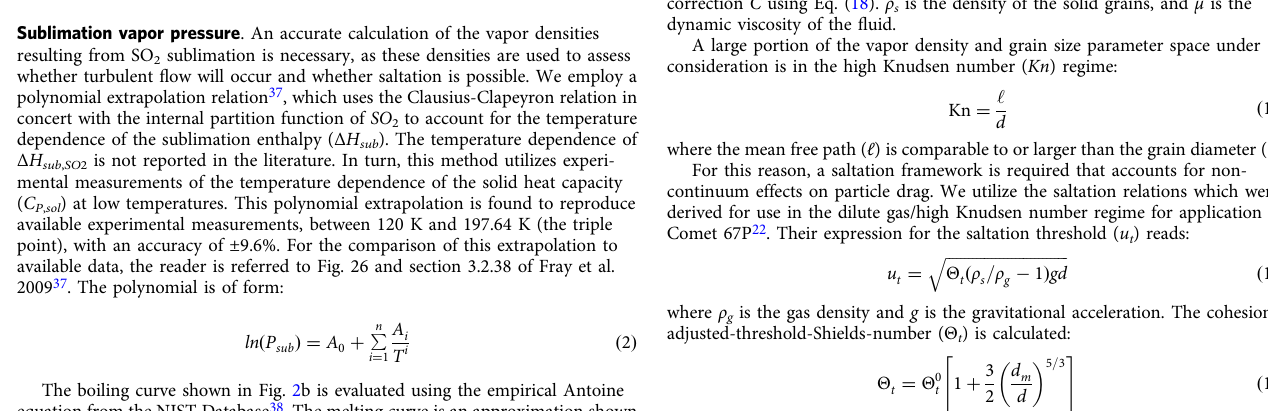
ffiffiffiffiffiffiffiffiffiffiffiffiffiffiffiffiffiffiffiffiffiffiffiffiffiffiffiffiffiffiffiffi Θ ð ρ t